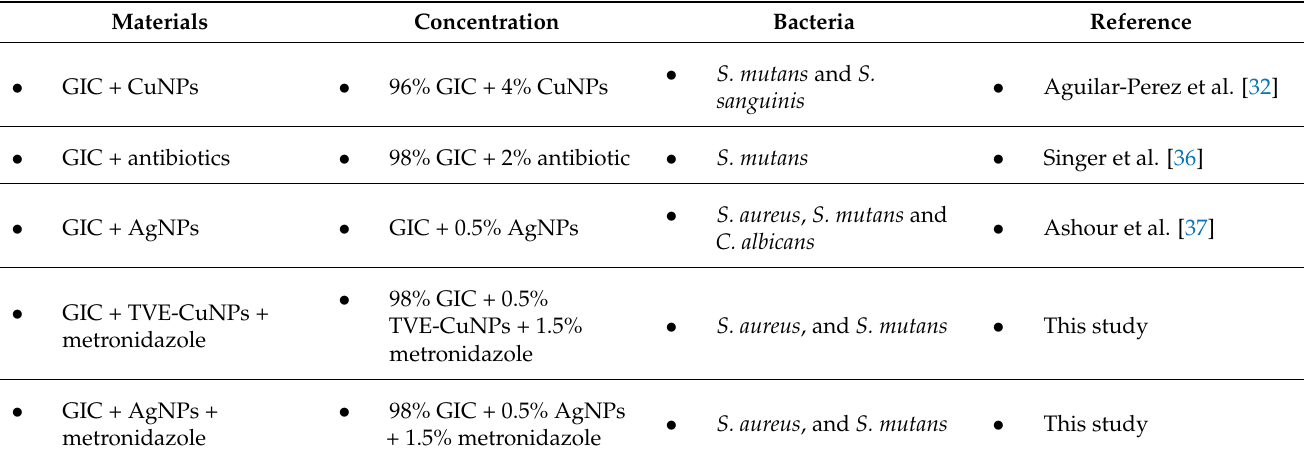
Table 4. Comparison of earlier research with restorative biomaterials for antibacterial activity against oral